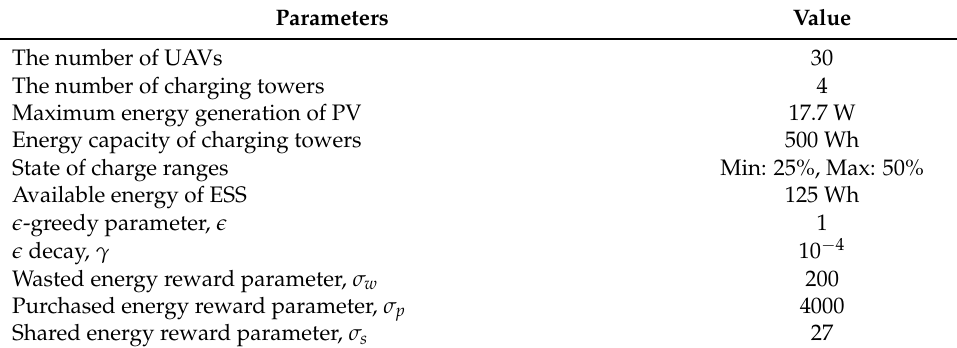
Table 1. Simulation-based performance evaluation